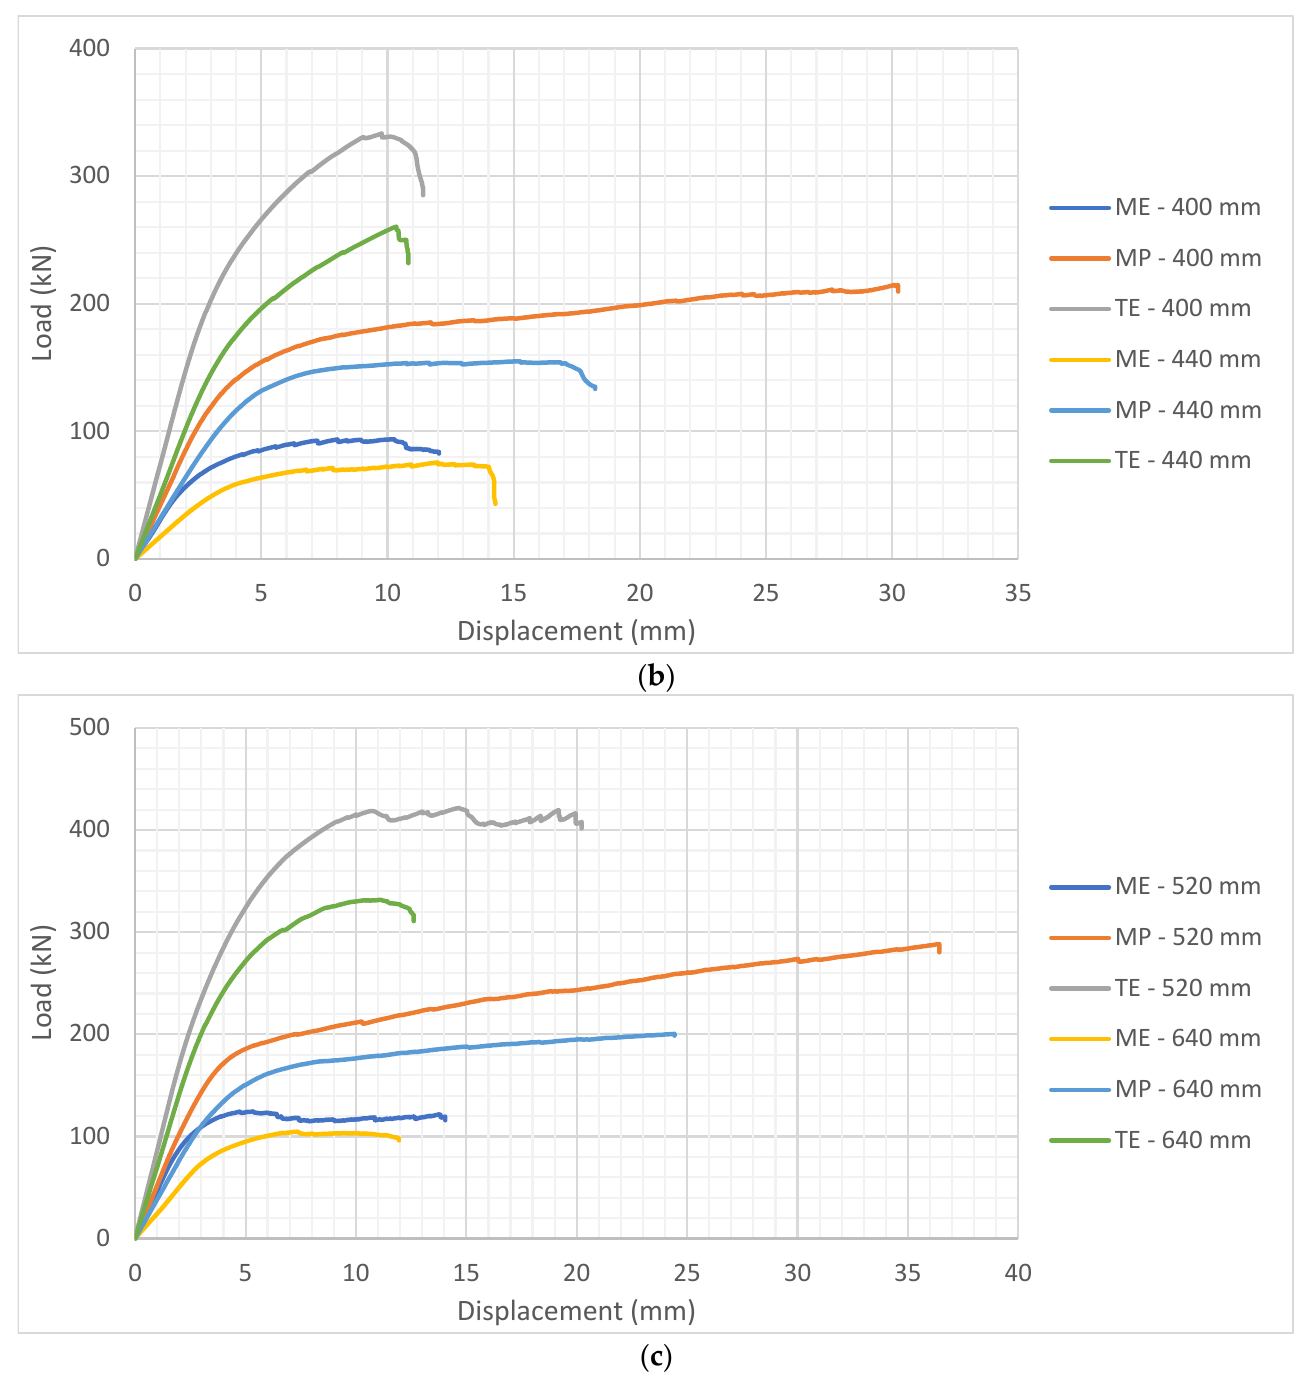
Figure 9. Characteristic load-displacement curves for each group of specimens: ( a ) Standardized specimens; ( b ) specimens loaded on edge of the element; ( c ) specimens loaded in the middle of the element.